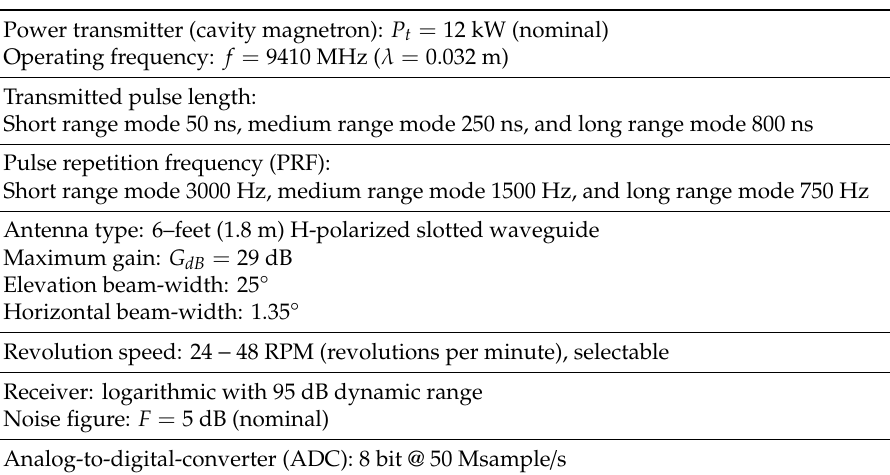
Noise figure: F = 5 dB (nominal) Noise figure: 𝐹 = 5 dB (nominal) Analog-to-digital-converter (ADC): 8 bit @ 50 Msample / s Analog-to-digital-converter (ADC): 8 bit @ 50 Msample/s